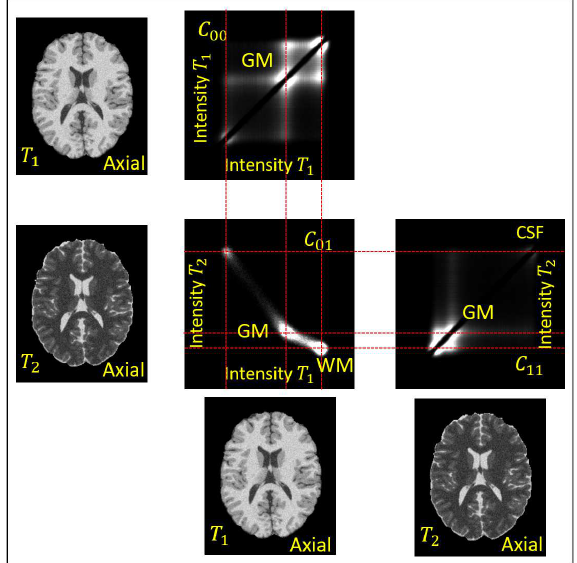
Figure 4. The auto-co-occurrence statistics and the joint-co-occurrence statistics of a T 1 and a T 2 image of the BrainWeb phantom without non-uniformity, b = 0%, and with noise of n = 5% [37]. The densities in the statistics are displayed in logarithmic scale. The individual distributions of the Gray Mater (GM), White Matter (WM), and Cerebrospinal Fluid (CSF) are